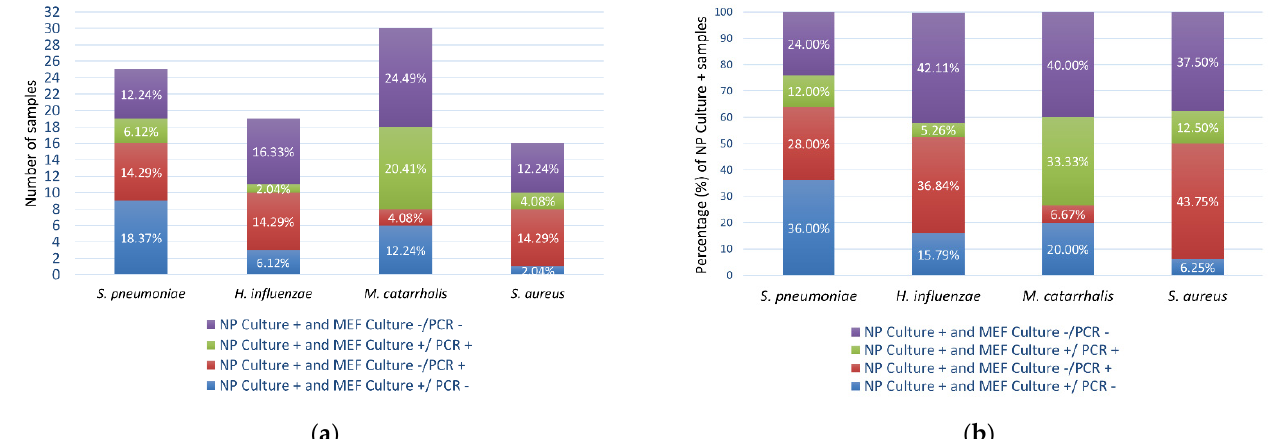
Figure 4. Correspondence between the nasopharynx and the middle ear fluid: ( a ) Number of bacterial isolates (percentage of total patients/samples) detected in the nasopharynx and middle ear fluid of the same patient; ( b ) Percentage of bacterial isolates detected in the middle ear fluid that were isolated from the nasopharynx.